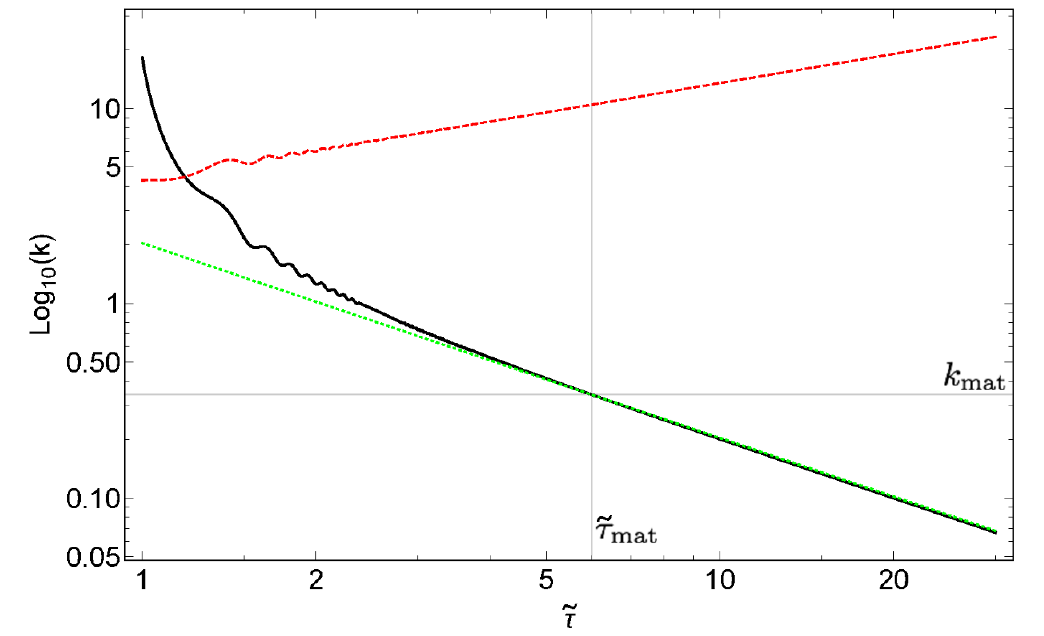
Figure 7 . Evolution of the comoving horizon aH (black) and of the comoving Jeans mode k J (dashed red). The green dotted line represents the relation between k and ~ (cid:28) in eq. (4.37). The horizontal and vertical lines correspond to k mat and ~ (cid:28) mat respectively. Figure 8 . Left panel : overdensity for the mode k = 1 normalized by the scale factor (cid:14) m,k =a (~ (cid:28) ), in log scale. Since during matter domination the matter overdensity increases as the scale factor, the curve tends to a constant value. We use arbitrary units on the y-axis. Right panel : newtonian potential for the mode k = 1. The initial value is normalized to (cid:30) k = (cid:0) 1. As expected during matter domination the Newtonian potential tends to a constant